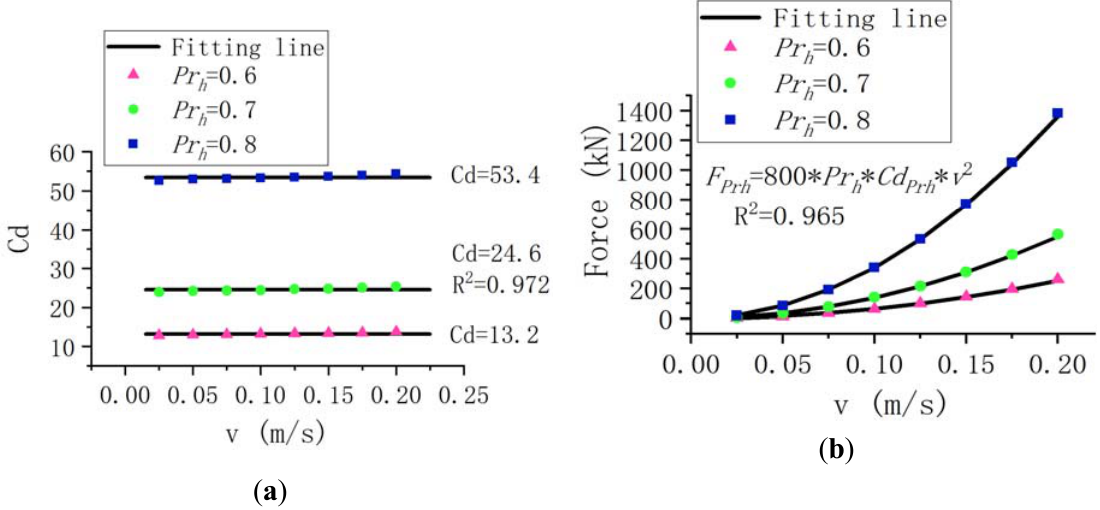
Figure 12. ( a ) Drag coefficient and ( b ) force at different inflow velocities (data sources: F1–F24).